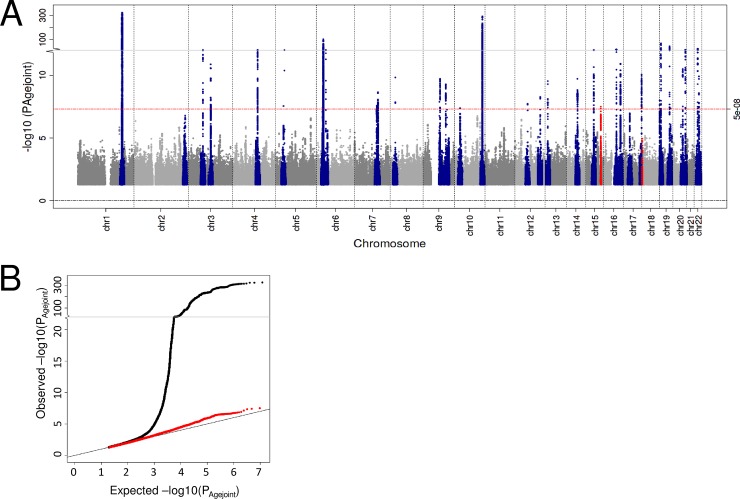
Manhattan and QQ plot of joint age-stratified 2df P-values.Shown are the age-joint P-Values (PAgejoint) for late AMD by their position on the genome (Manhattan plot) as well as their distribution (QQ plot). In the Manhattan plot, the 34 known genetic regions identified by Fritsche et al [13] are colored blue and additional genome-wide significant signals are colored red. The QQ plot shows the distribution of PAgejoint including all variants (black) as well as after exclusion of known loci (34 variants +/-500kb, red).